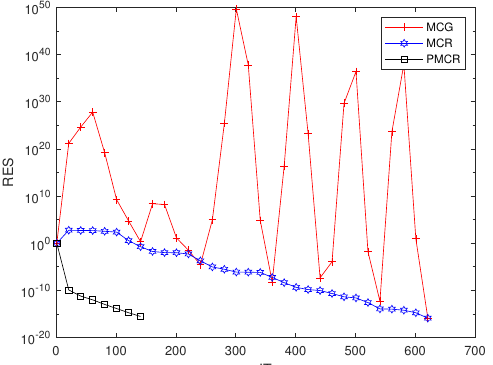
Figure 1. Convergence history of Example 1, I 1 = 15, I 2 = 15, I 3 = 20.